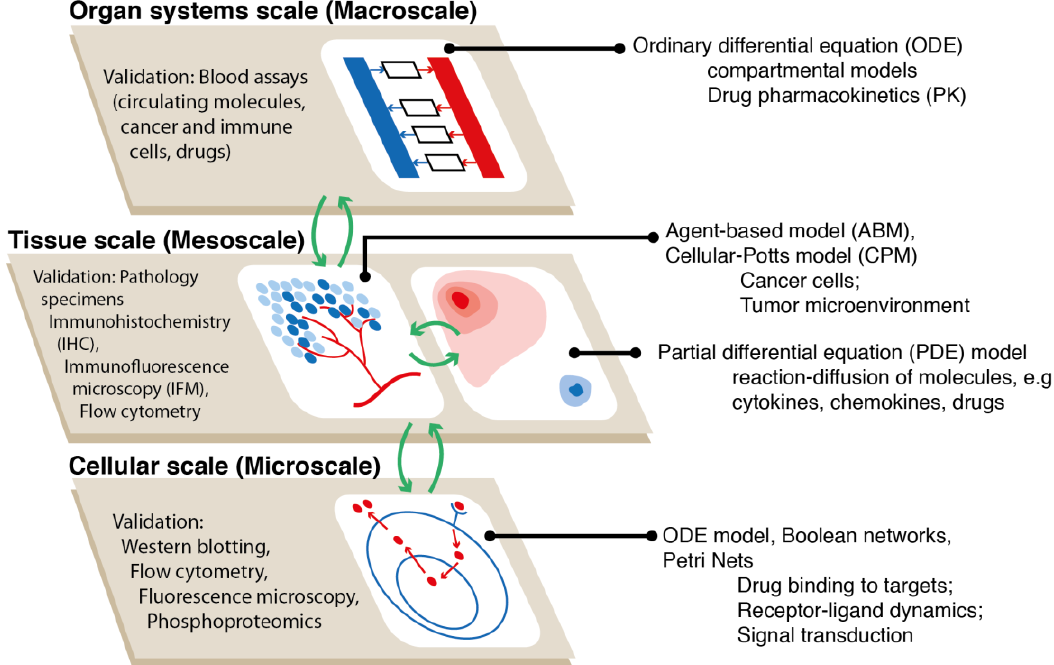
Figure 2. Using hybrid models to study immuno-oncology. While agent-based models are ideal tools to recapitulate the spatio-temporal dynamics of cancer cells and the tumor microenvironment at the tissue scale, the mechanisms at other biological scales can be efficiently embodied using other types of mathematical representations; however, agent-based models (ABM) can also be used at any scale. Such multi-scale hybrid models increase the flexibility in model construction, improve computational performance, and enhance model credibility by allowing comparison between model output and a wide range of experimental and clinical observations.